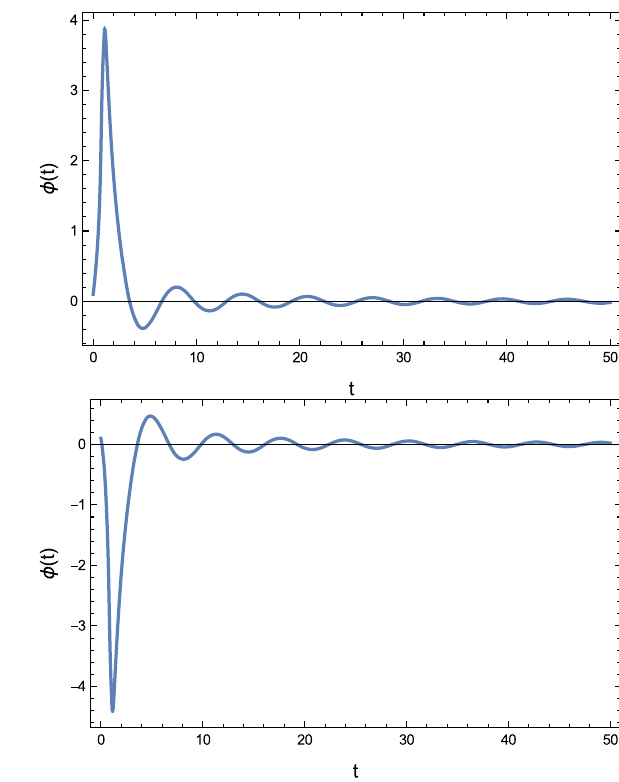
Fig. 8 Time evolution of the two-sphere for scalar-matter interaction. Forthegraphontop,thechoiceof a 0 > 0isvaried(bluecurve a 0 = 0 . 1, yellow curve a 0 = 0 . 5, green curve a 0 = 1) while other parameters are kept fixed ( ρ 0 = 10, ψ 0 = 0 . 1). For the graph on bottom, a 0 < 0 is varied (blue curve a 0 = − 0 . 5, yellow curve a 0 = − 1, green curve a 0 = − 1 . 5) while other parameters are kept fixed ( ρ 0 = 10, ψ 0 = 0 . 1)